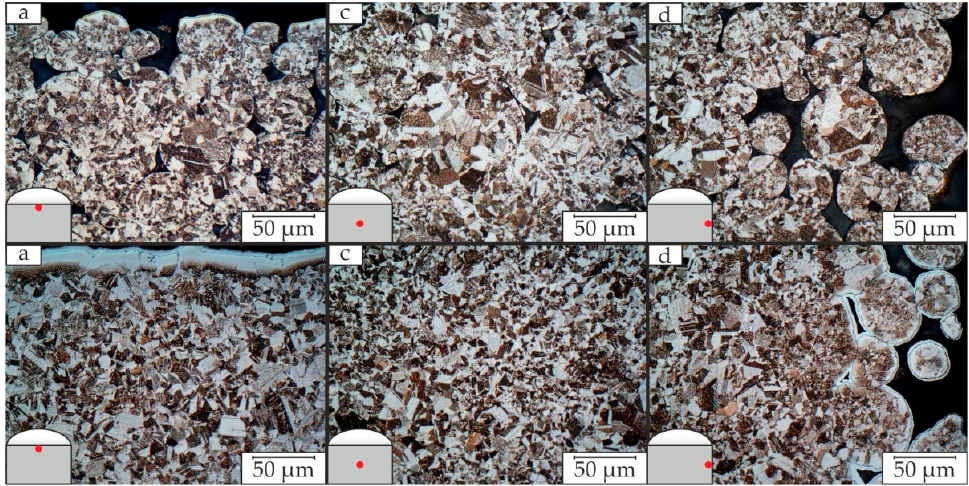
Figure 8. Microstructure in defined positions a, c and d according to Figure 1 (right) of GE48 samples sintered at 1200 °C, with 2 min dwell time and 30 MPa pressure (top) and 10 min dwell time and 65 MPa pressure (bottom).